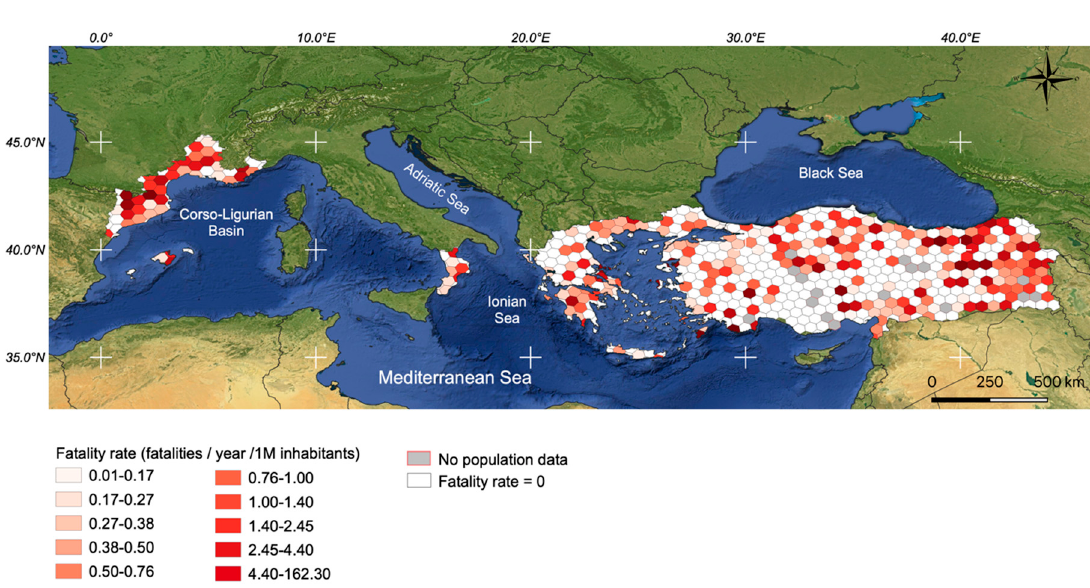
Figure 6. Fatality rate by 50 × 50 km grid cell based on the quantile classification excluding 0.00 values.